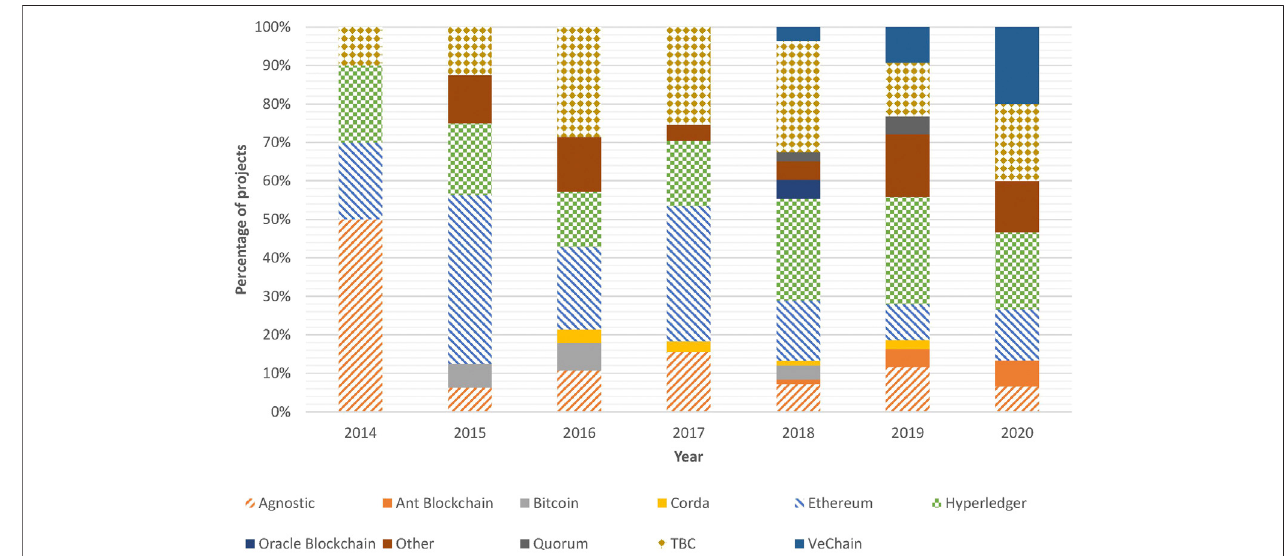
FIGURE 2 | The percentage of projects using a particular blockchain based on the project ’ s year of creation.